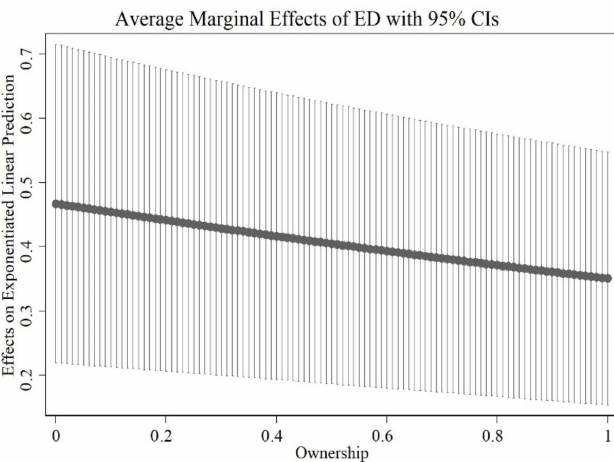
Figure 2. The marginal effect of environmental dynamism on technological diversification over ownership. Hypothesis 4 predicts that state ownership positively moderates the relationship between environmental munificence and technological diversification. In Model 5a, we find that the coe ffi cient of environmental munificence is still negative and significant, indicating that the finding of Hypothesis 2 is rather robust. The interaction term of state ownership and environmental munificence is positive and significant ( β = 0.171, p < 0.01). The marginal e ff ect of the interaction terms on its means in Model 5b also indicates the same result ( β = 0.086, p < 0.01). Figure 3 elaborates the marginal e ff ect of environmental munificence on technological diversification through state ownership. We can see from Figure 3 that the marginal e ff ect increases with ownership, indicating a positive moderating role. In conclusion, Hypothesis 4 is supported.